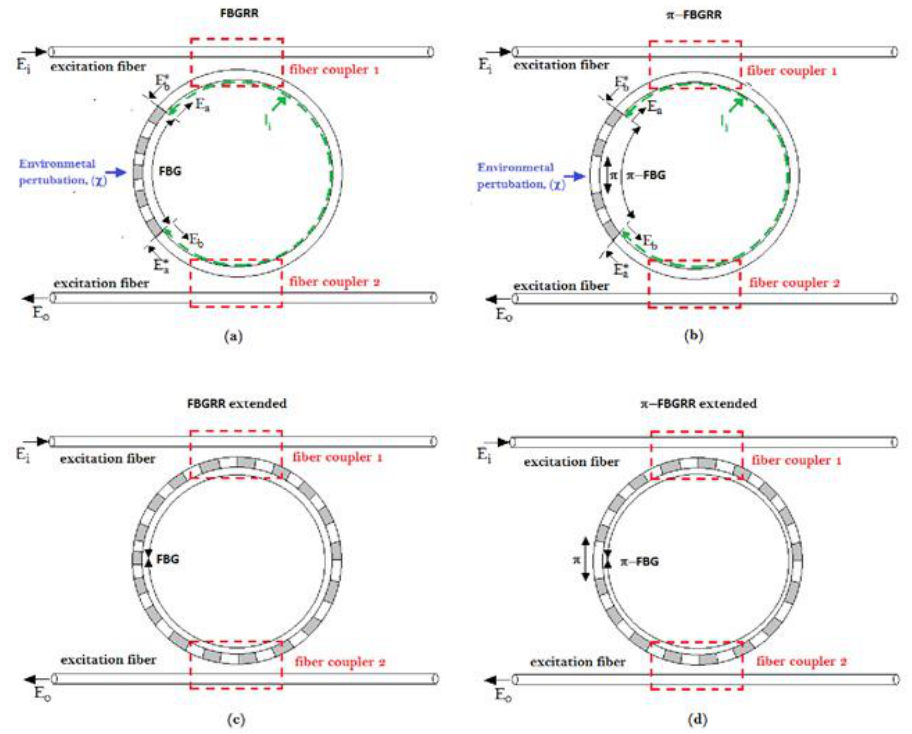
Figure 11. ( a ) FBGRR; ( b ) π-FBGRR; ( c ) extended version of FBGRR; and ( d ) extended version of π-FBGRR.